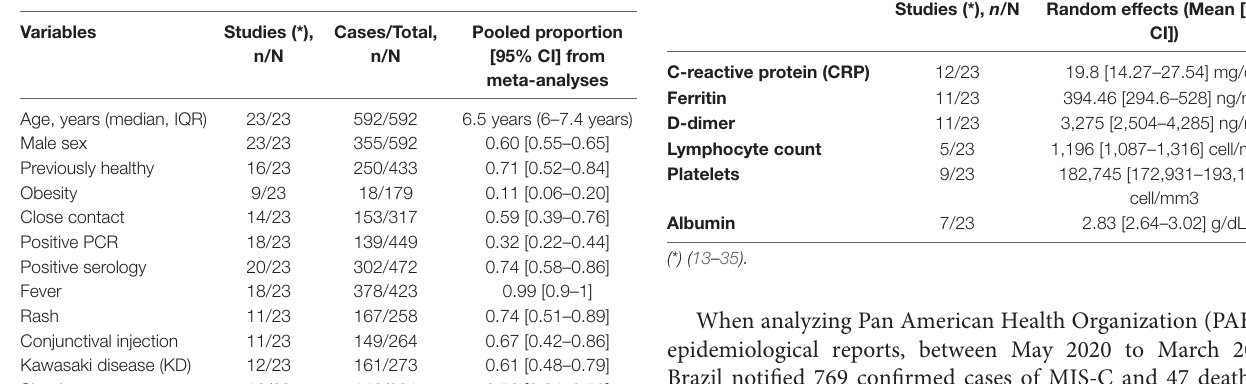
TABLE 3 | Laboratory findings, pooled results: Cases/Total, Pooled proportion n/N n/N [95% CI] from